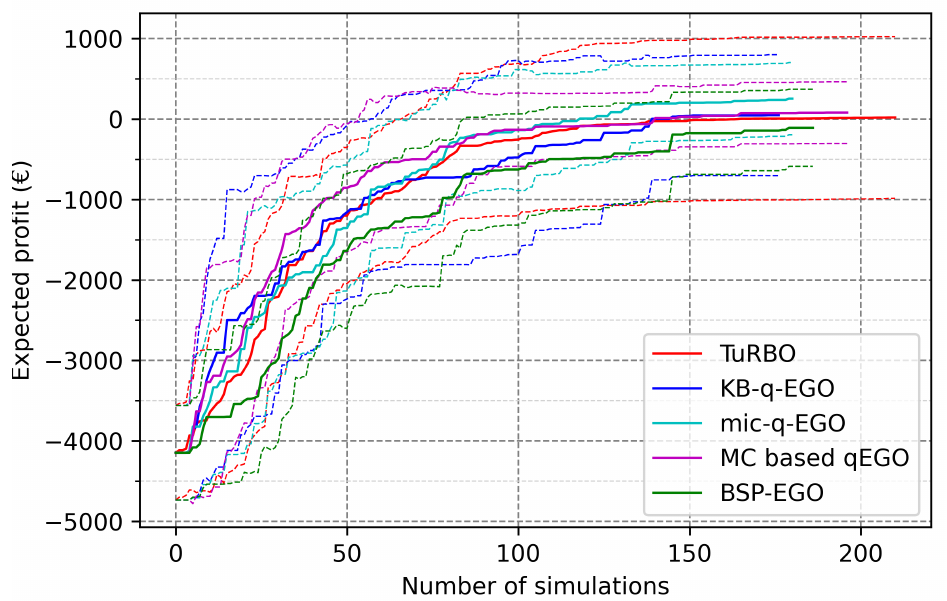
Figure 4. Evolution of the best-known objective value according to the number of executed cycles with n batch = 2. Solid lines indicate the average over 10 runs, and dashed lines of same colors indicate the standard